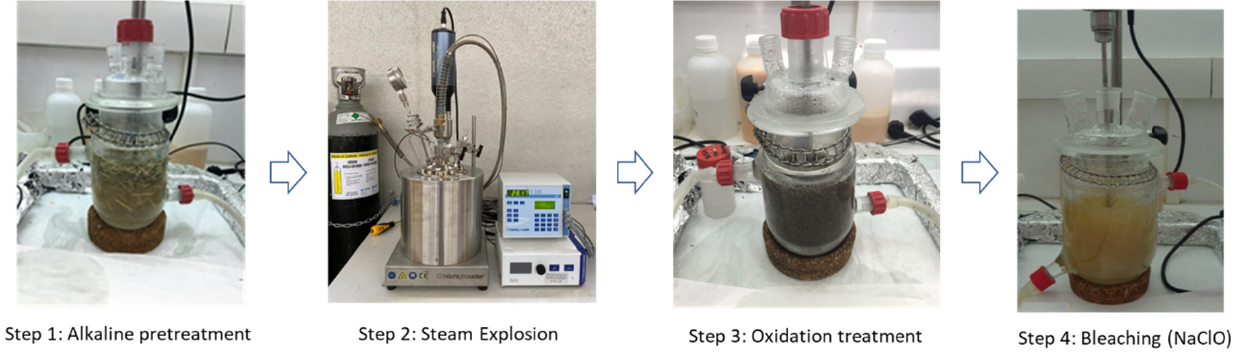
Figure 2. Extraction process to obtain cellulose fibers from palm leaves waste.